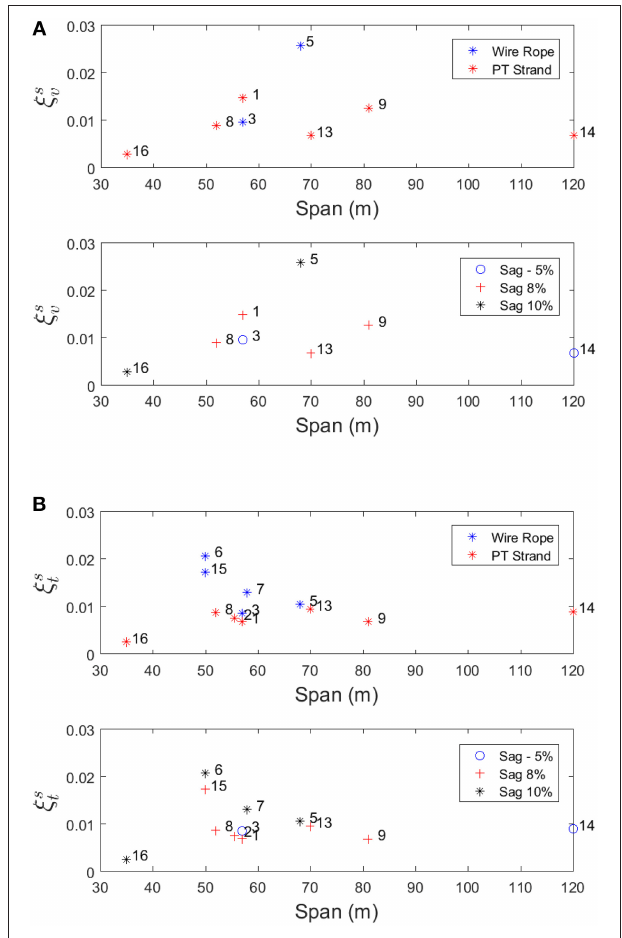
FIGURE 15 | Vertical (A) and torsional (B) symmetric damping ratios of